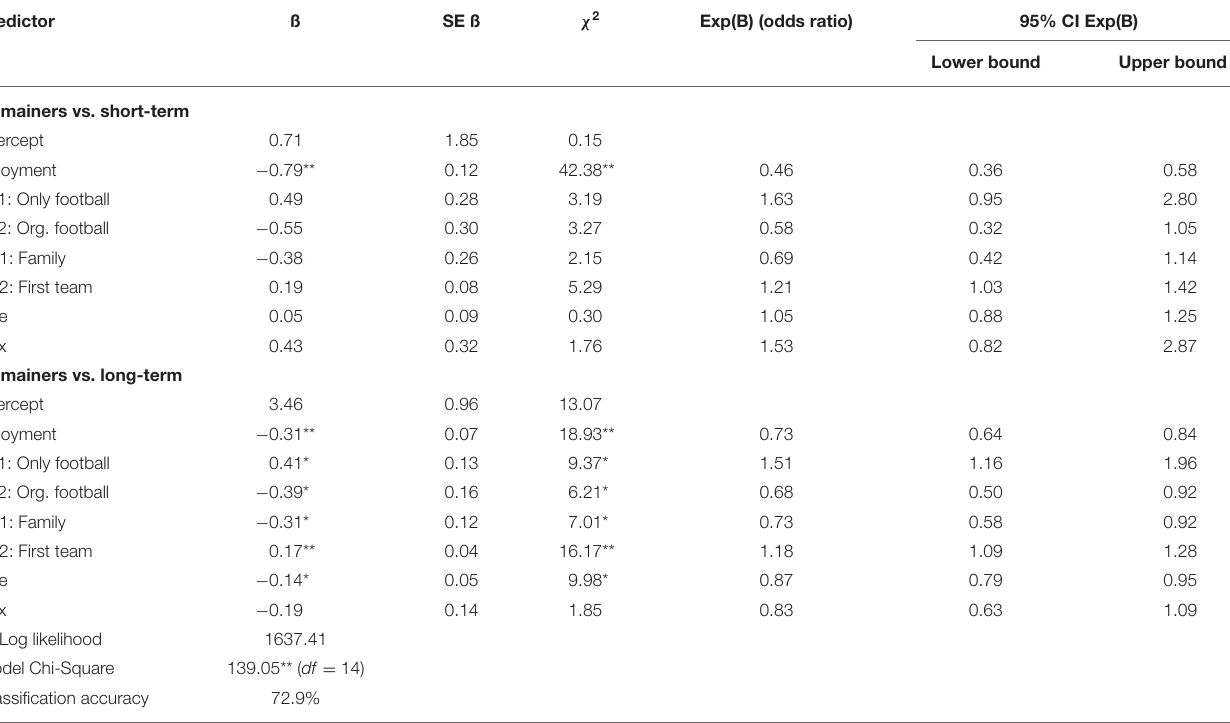
TABLE 2 | Logistic regression results with dropout from organized football (remainers vs. short-term dropouts vs. long-term dropouts) as the dependent variable. Predictor